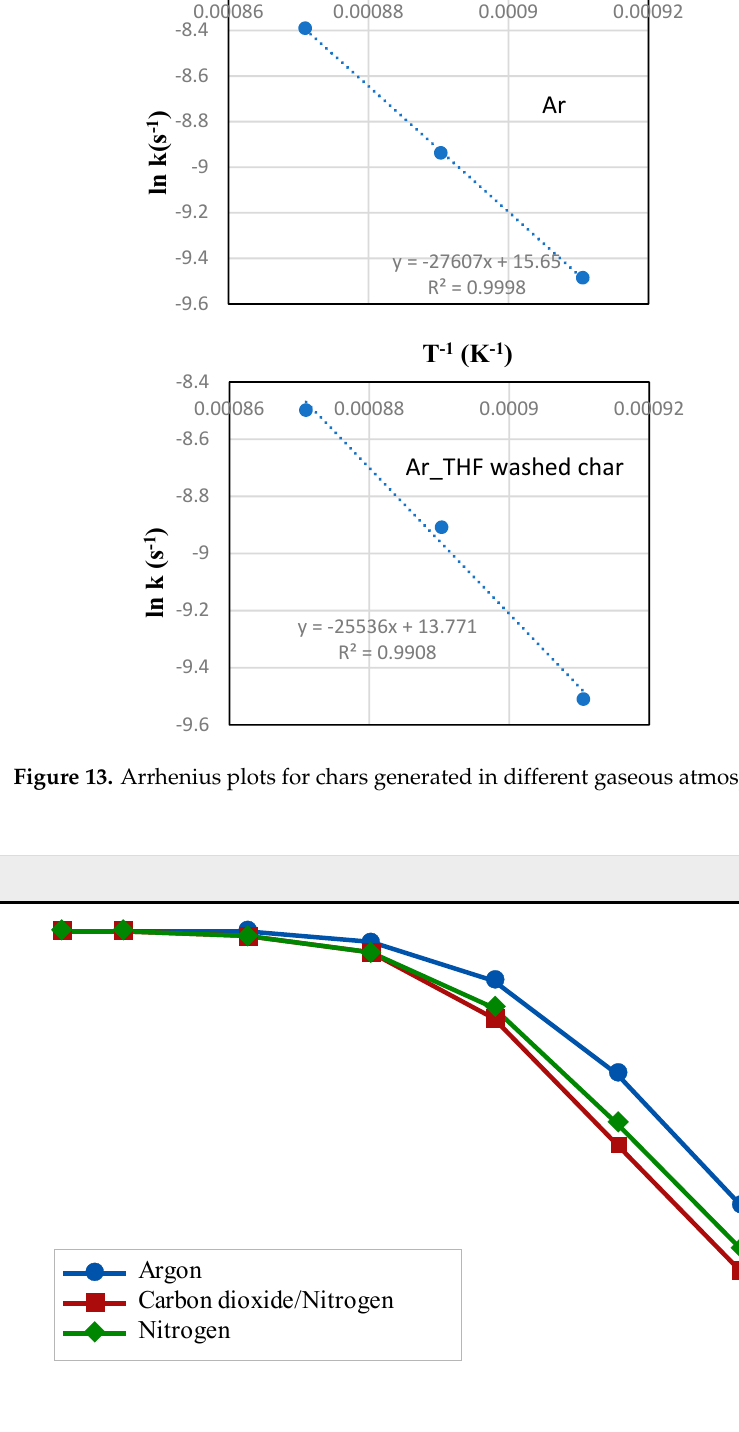
2 reaction at 6.2